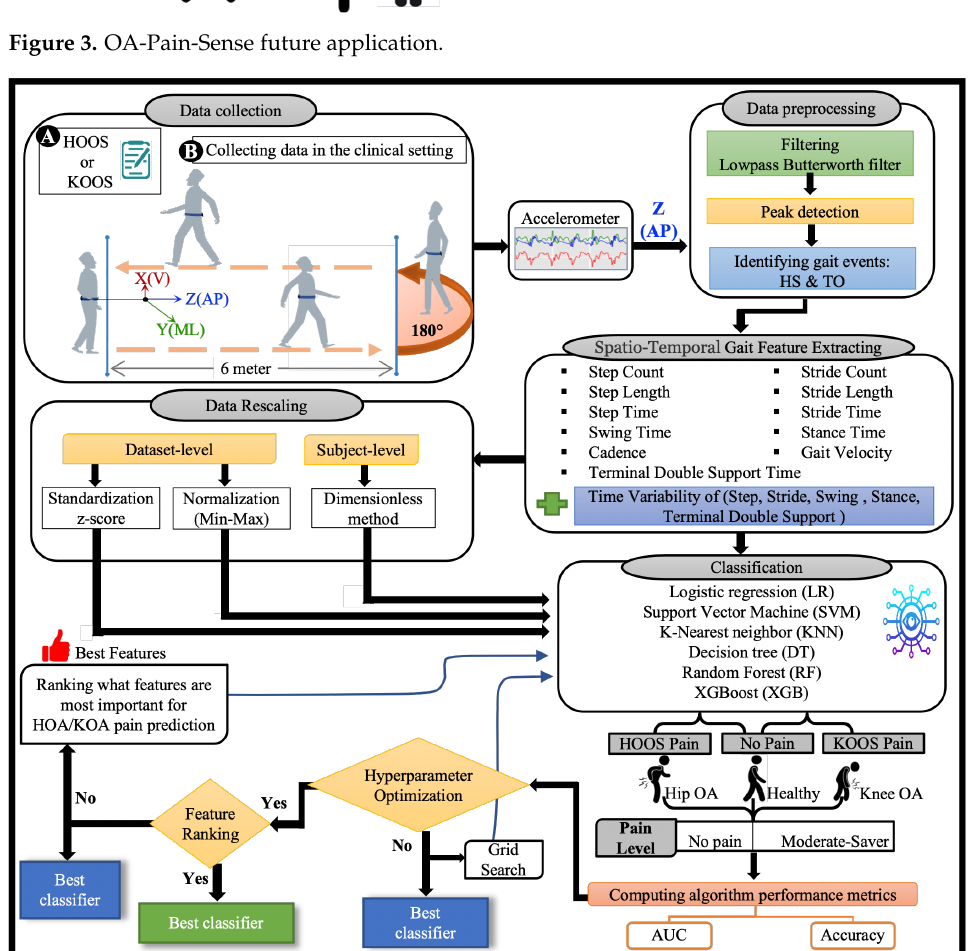
Figure 4. The OA-Pain-Sense framework shows four different experimental datasets used as input to the classification models. The data collection block shows the IMU location on a subject’s lower back for the 2 min walk trails. The raw accelerometer signal in the Anterior-Posterior (AP) direction is input into the data pre-processing block to filter and detect heel strikes and toe-off events. The STGPs are computed after the pre-processing step and fed to the ML classification algorithms (first dataset). STGPs are passed to the data rescaling block to apply dataset-level (two methods: z-score and min- max) and subject-level (one method: dimensionless) normalization and then fed to ML